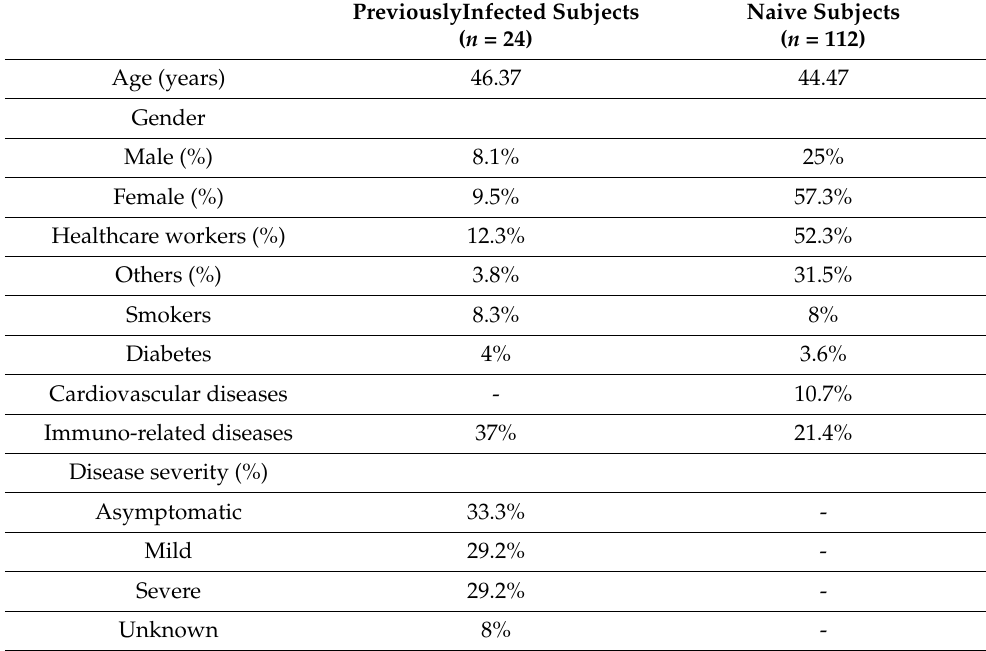
Table 1. Cohort participant